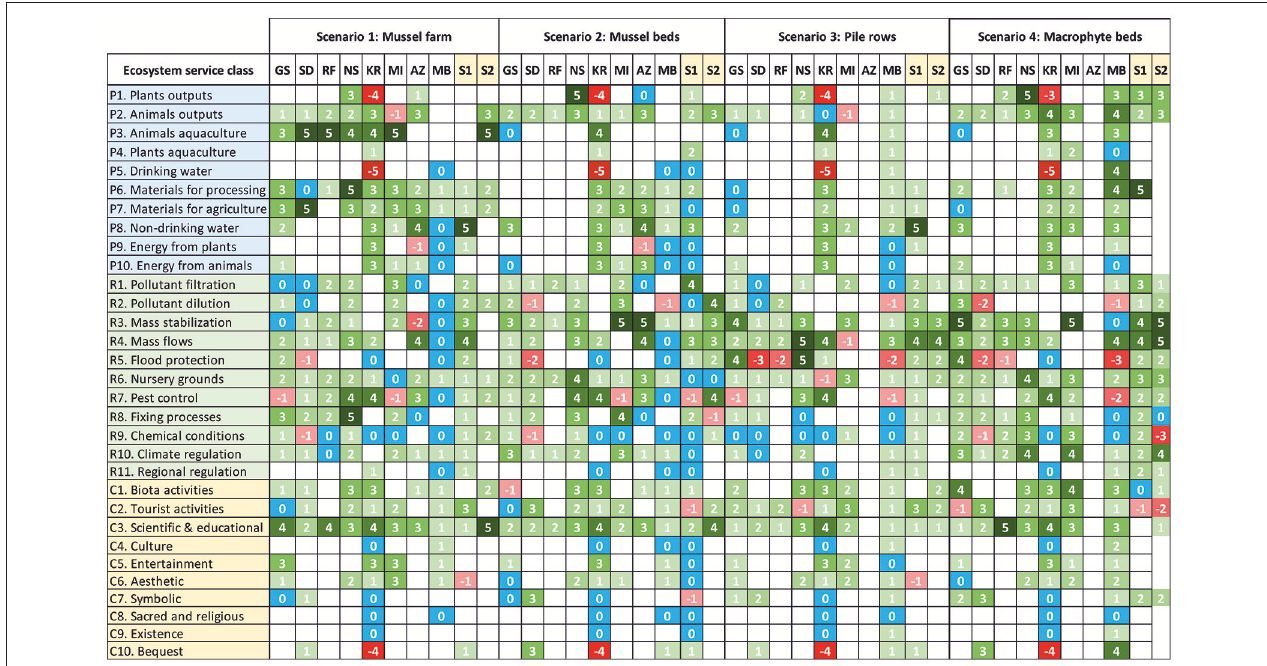
FIGURE 6 | Comparison of the present state of the lagoon with the hypothetical assumption of an implementation of 4 concrete, realistic, alternative scenarios. The assessment was carried out by 8 experts (GS, SD, RF, NS, KR, MI, AZ, MB) and 2 master-student groups (S1, S2). Abbreviations indicate provisioning (P), regulating and maintenance (R) as well as cultural ES